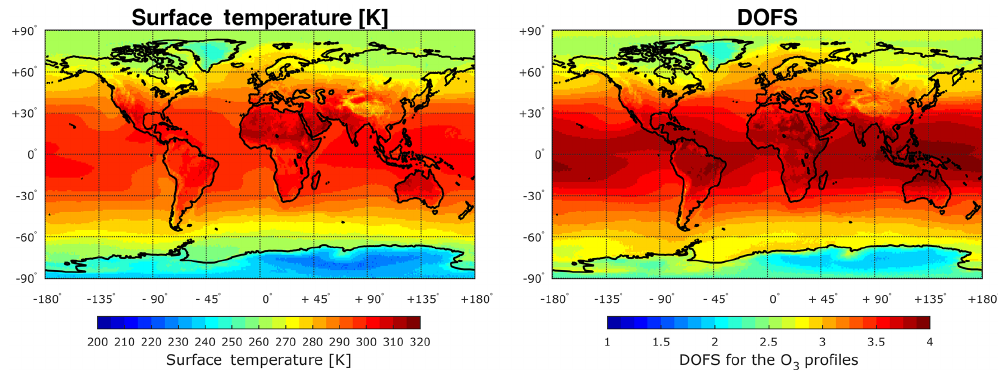
Figure 2. Global distribution averaged over 1 ◦ × 1 ◦ for the period 2008–2014 for daytime measurements: (left) IASI surface temperature and (right) DOFS for the O 3 profiles. Table 1. Mean values of surface temperature (K) and DOFS for the O 3 profiles for different seasons and latitude bands for the period 2008–2014 for daytime measurements. The standard deviation is also indicated. Latitude